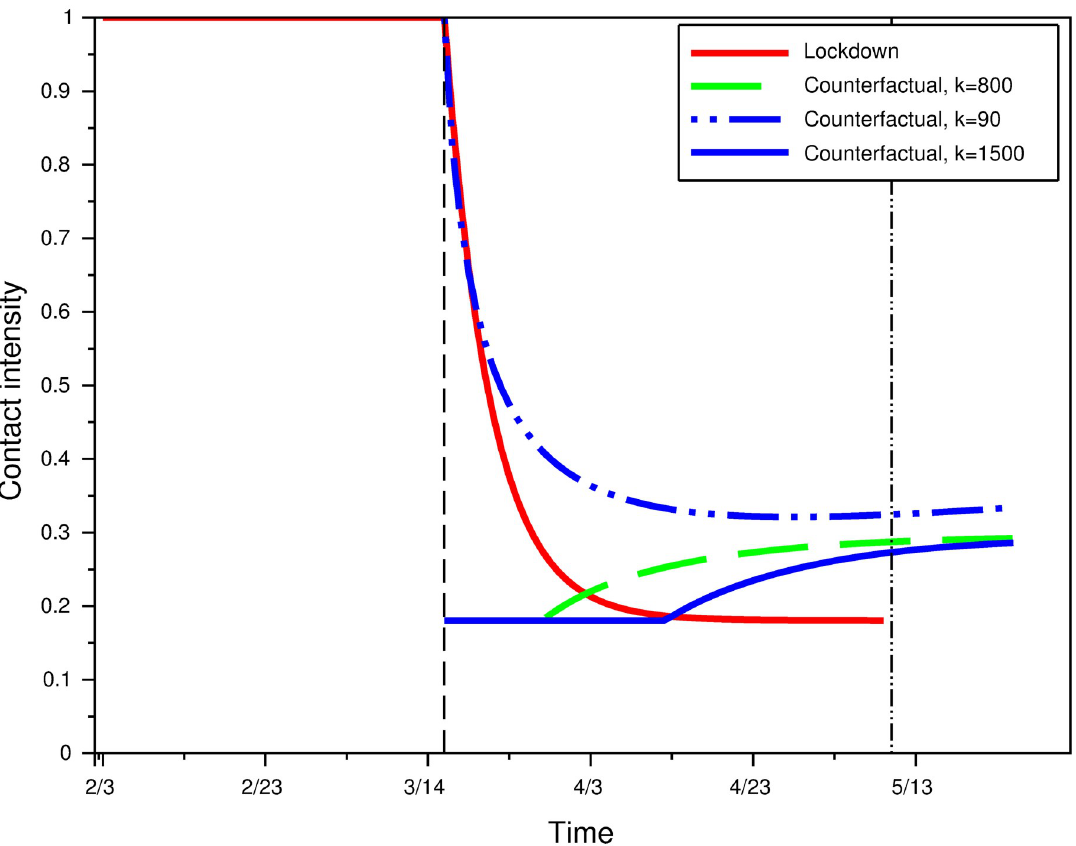
Fig 4. Contact intensity under actual lockdown, and counterfactual rational equilibrium contact intensity for different prevalence weights k .